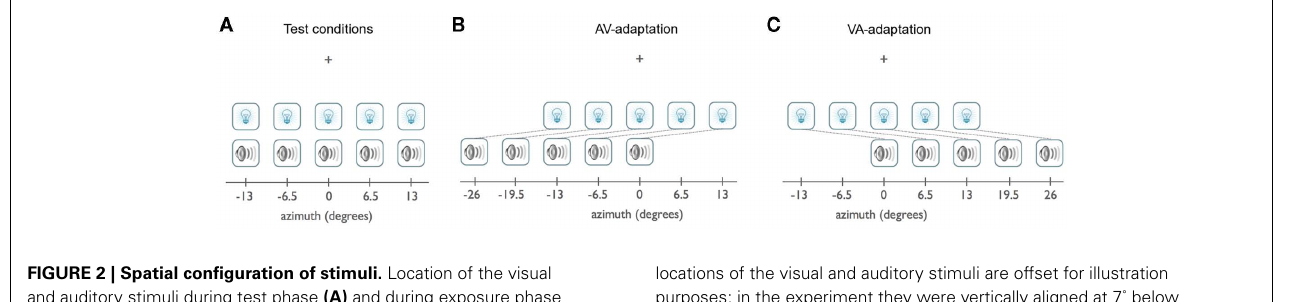
locations of the visual and auditory stimuli are offset for illustration purposes; in the experiment they were vertically aligned at 7˚ below fixation. All combinations of visual and auditory stimulus locations were presented during test phases (A)